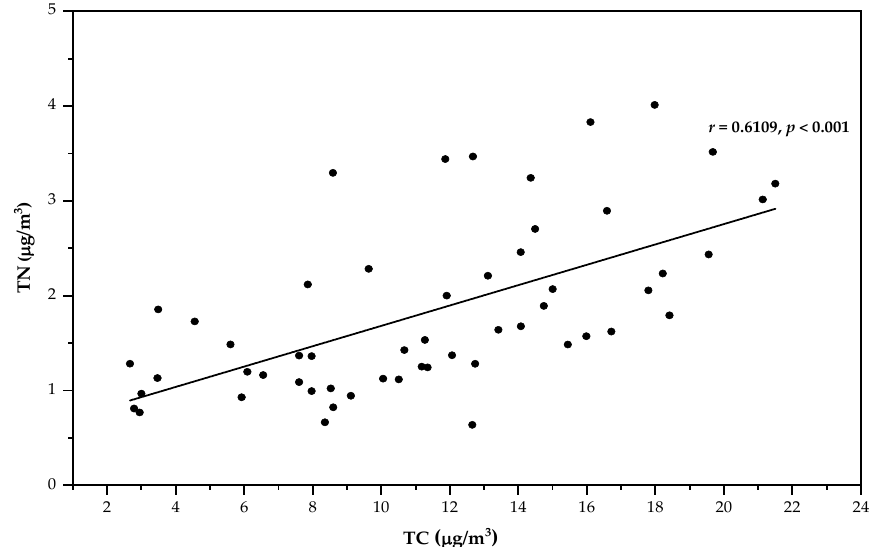
Figure 5. Correlation plot between TC and TN during the sample period from January to May in Chiang Mai city.